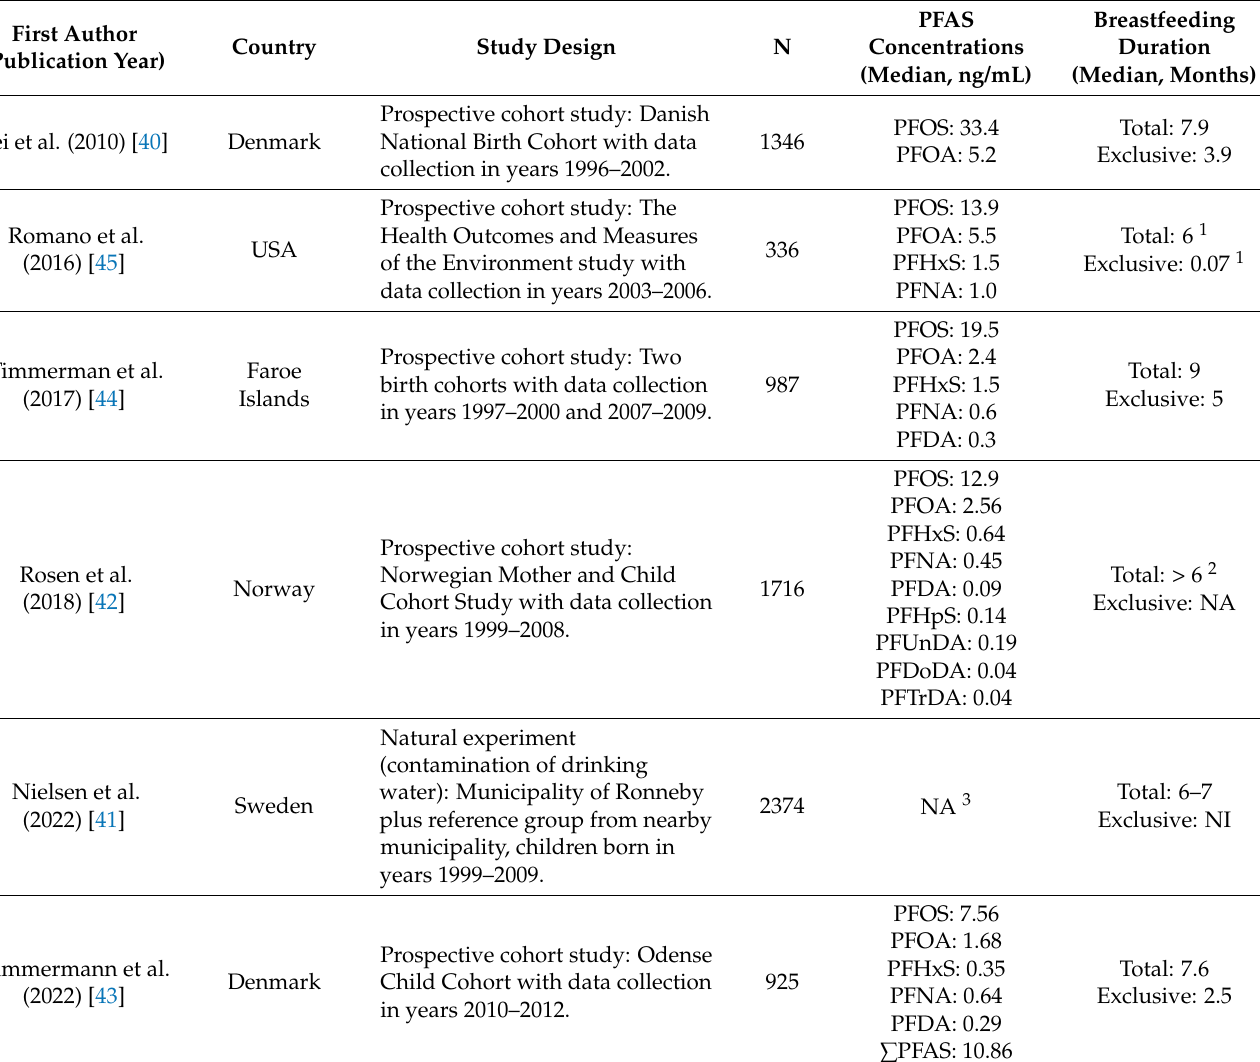
Table 3. Studies included in the